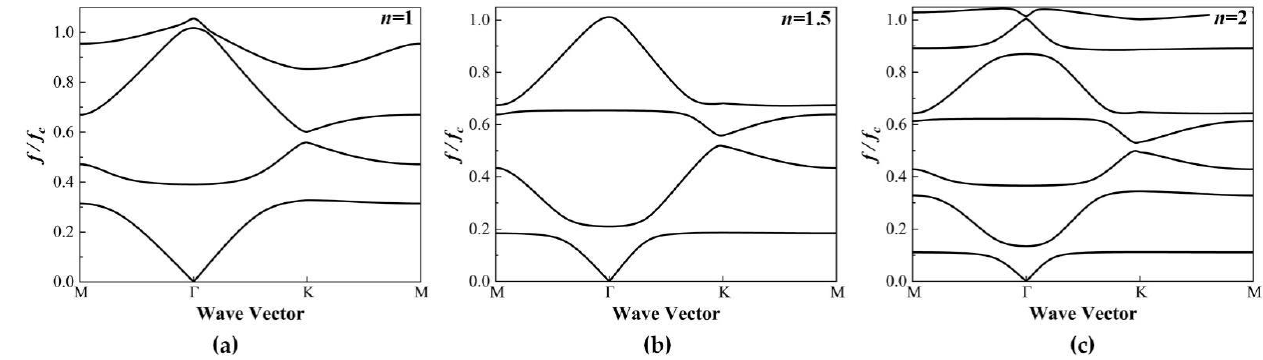
Figure 4. The energy band of the spiral structure with the number of turns n = 1, 1.5, and 2.